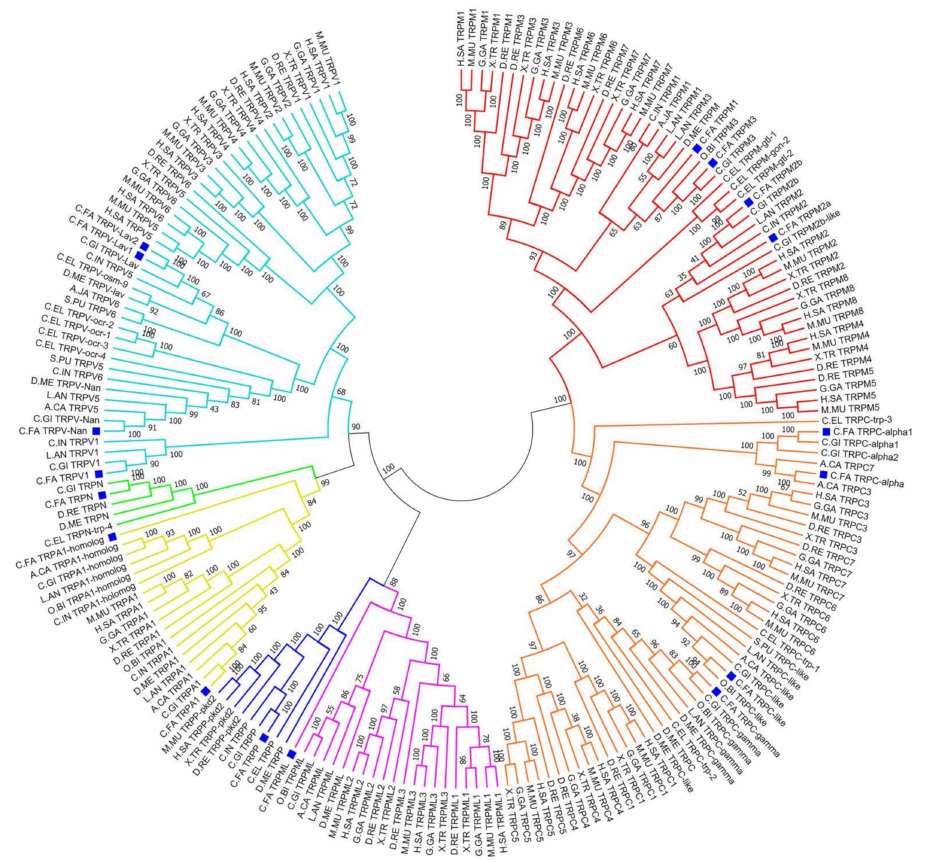
Figure 3. A phylogenetic tree was constructed based on the protein sequences of TRP from C. farreri and other selected species using neighbor-joining method with bootstrapping of 1000 pseudo replicates. C.FA TRPs are marked with blue squares. Branches of different subfamily are highlighted with different color. (TRPM subfamily: red, TRPC subfamily: orange, TRPA subfamily: yellow. TRPN subfamily: green; TRPV subfamily: light blue; TRPP subfamily: dark blue; TRPML subfamily: purple.) C.FA , C. farreri ; H.SA, H. sapiens ; M.MU, M. musculus ; G.GA, G.gallus ; X.TR, X. tropicalis ; D.RE, D. rerio